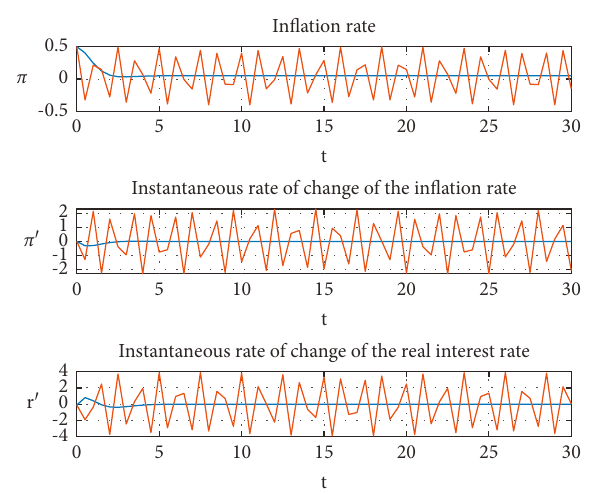
Figure 19: Time paths of the interest rate and instantaneous rates of change of inflation and the interest rate (for I 2 and with β 10). β β 0 (cid:31) (cid:31)